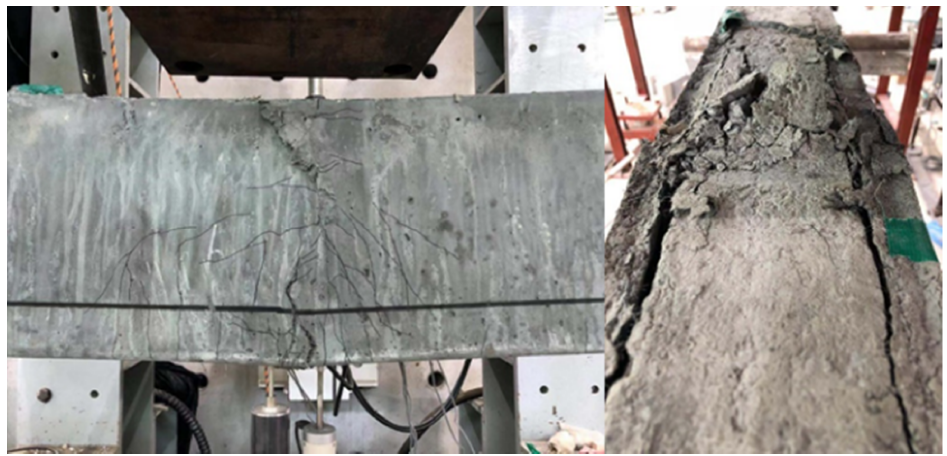
Figure 10. Compressive failure (B-3J).